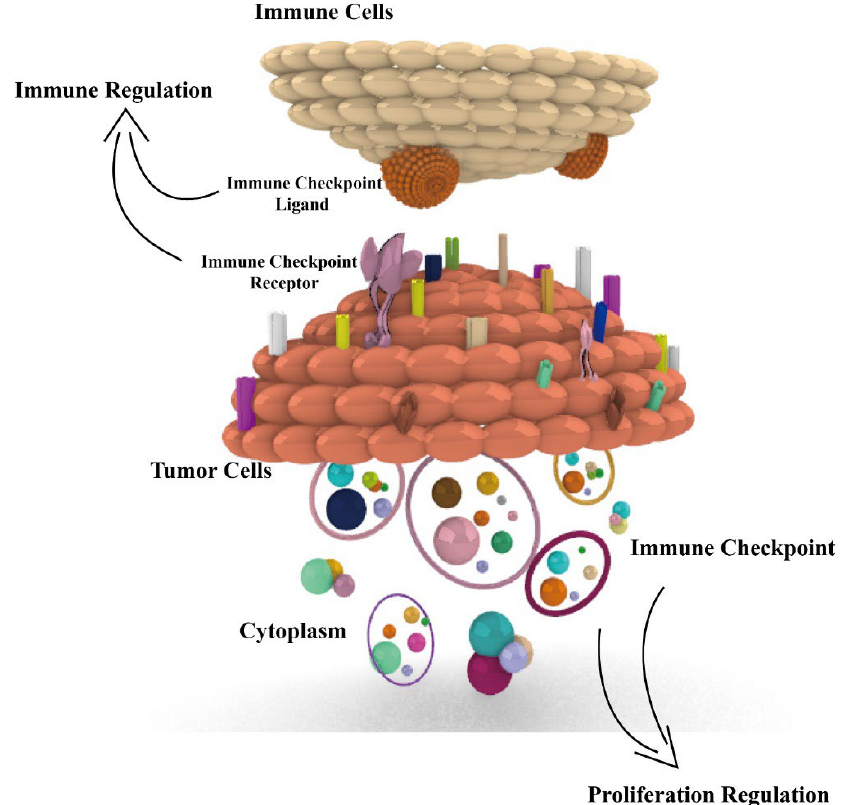
Figure 1. Dual immunological and proliferative regulation roles of immune checkpoints in tumors. Fifteen immune checkpoints, including PD1, PD-L1, FGL1, CD155, CD47, SIRP α , CD276, IDO1, SIGLEC-15, TIM3, Galectin-9, CD70, CD27, 4-1BBL, and HVEM, all exert dual immunological and proliferative regulation of immune checkpoints in tumors. The related proliferation regulation mechanisms are